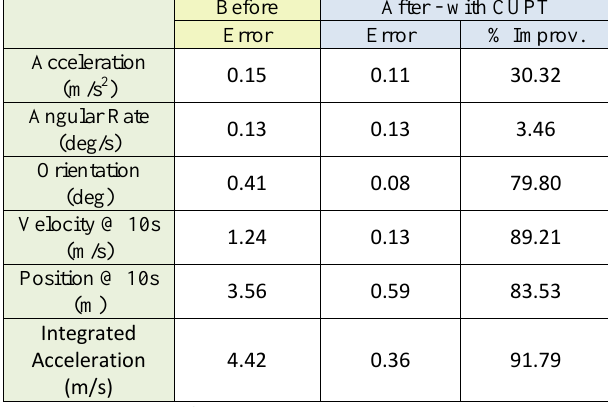
Table 3: RMSE of the input signals and estimated navigation quantities before and after in-situ user self-calibration for the walking trial (with the IMU close to the